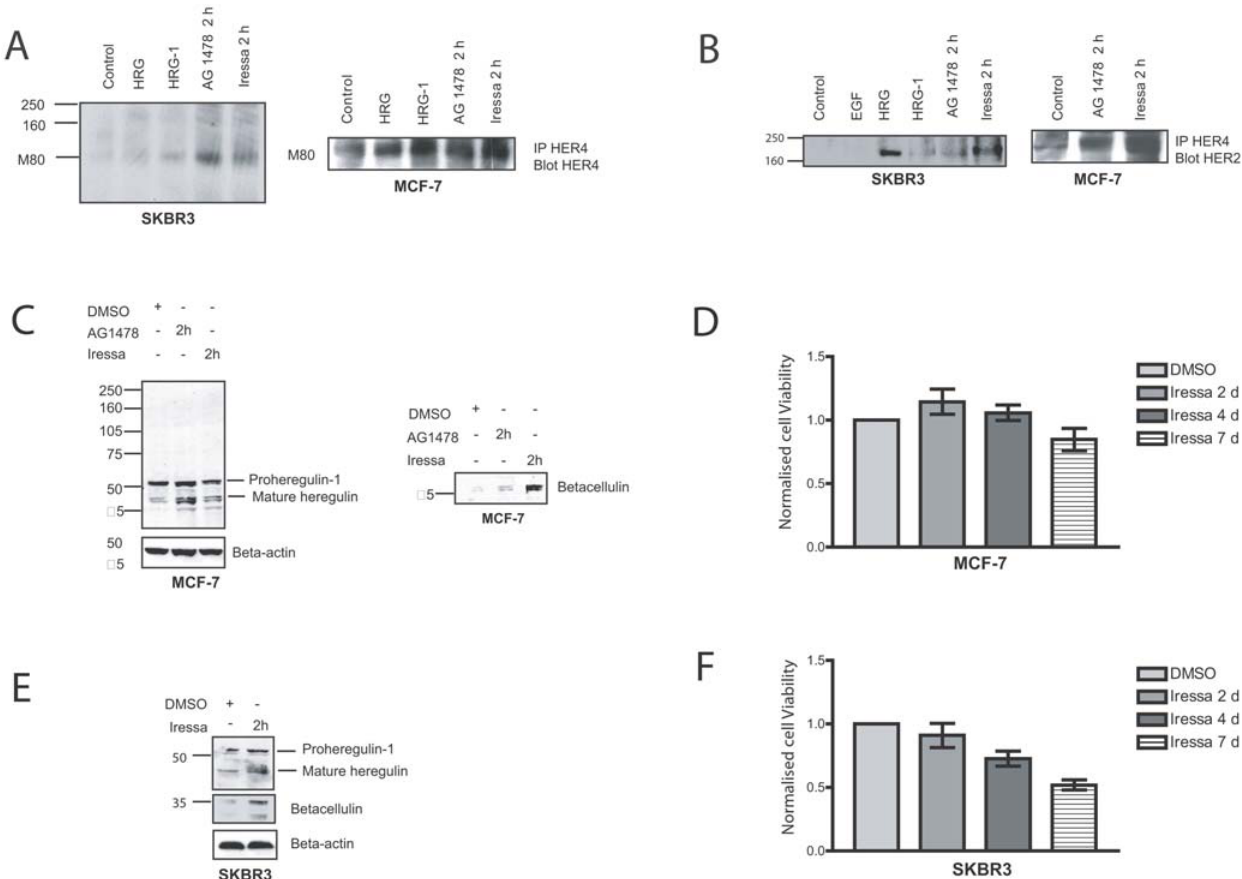
Figure 2. AG 1478 and Iressa induce proteolytic cleavage of HER4 and dimerization between HER2 and HER4 in breast cancer cell lines via the autocrine ligand release. A, HER4 was immunoprecipitated from SKBR3 and MCF-7 cells after being treated with the conditions illustrated. Following the immunoprecipitation, the cell lysate was probed by western analysis for total HER4. B, HER4 was immunoprecipitated from both SKBR3 and MCF-7 cell lysates after treatment under the conditions illustrated. Extracts were probed with anti-HER2 antibody. C, MCF-7 cells were treated with either 3 m M AG 1478 or with 1 m M Iressa for 2 hours before the cells were lysed. 10 m g of protein was loaded in each lane for SDS- PAGE and the membrane was probed with an antibody recognizing proheregulin-1 or betacellulin. D MCF-7 cells were grown in 24-well plates after seeding around approximately 30,000 cells per well and left to grow for at least 24 hours before treatment with either DMSO or 1 m M Iressa for the different durations. The viable cells were counted in a cell viability analyzer using Trypan Blue to stain dead cells. E, Near confluent SKBR3 cells were pre-treated with Iressa or DMSO for 2 hours as illustrated before the cells were lysed for western blot experiments. The membrane was probed with antibodies recognizing proheregulin-1 and betacellulin with anti- b -actin antibody used as loading control. F, SKBR3 cells were grown in 24-well plates after seeding around approximately 30,000 cells per well. They were treated with either DMSO or 1 m M Iressa for the different durations and the viable cells were counted in a cell viability analyzer and normalised to the